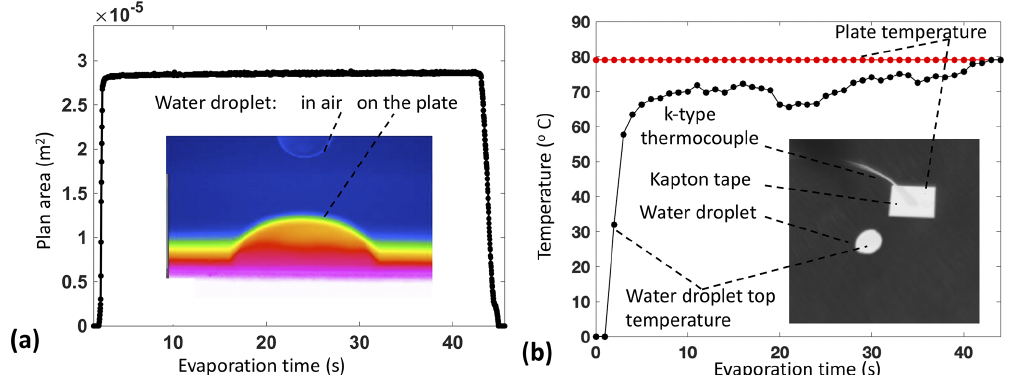
Figure 5. (a) Time series of the plan area of a water droplet during evaporation and a side-view temperature contour plot of a water droplet before and after impact on the DEID plate. (b) Time series of the temperature of the plate and the top of the water droplet. The water droplet was applied with a pipettor seen as the bright round region. A rectangular piece of Kapton ® tape ( (cid:15) ≈ 0 . 95) and a k-type thermocouple were used to calibrate the temperature of the plate and water droplet.